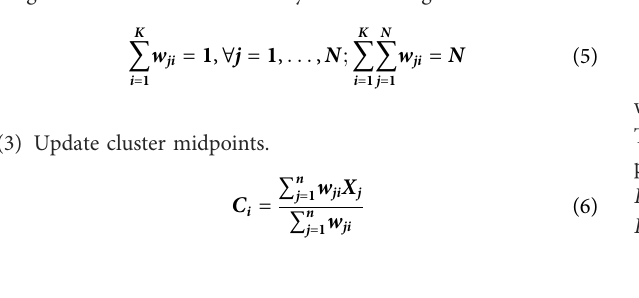
TABLE 1 Grid-connected power fl uctuation index of China. The installed capacity of new energy power stations (MW)